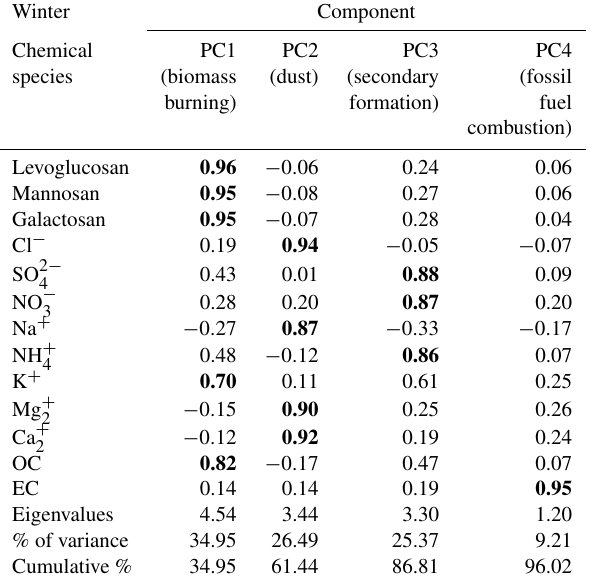
Table 2. Source identification of chemical species using principal component (PC) analysis and varimax rotation at Ulaanbaatar, Mon- golia, during the winter of 2017. Bold values show high loadings of chemical species.